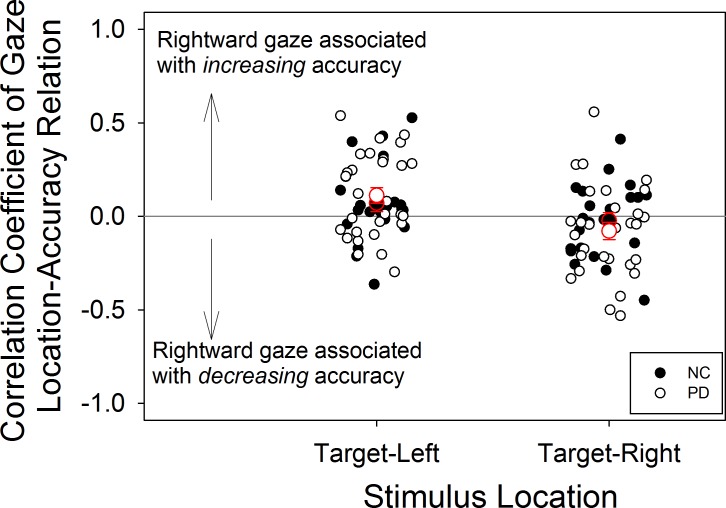
Relation between gaze location and accuracy for experiment 1.Group averages are shown with red outlines, and these indicate that the relation between gaze location and accuracy across subjects was weak, despite some medium strength correlations in individual subjects.